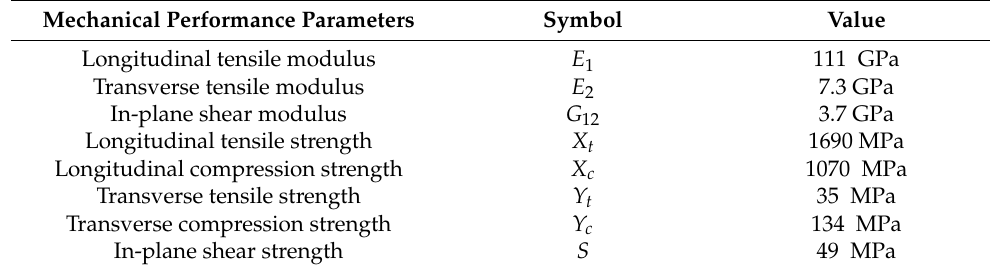
Table 1. ZPNPREG ® 2551/150/37 parameters.